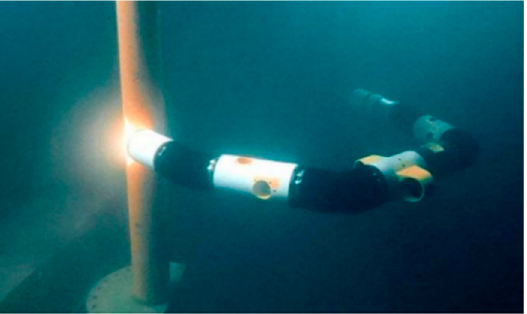
Figure 3. The Biotic AIAUV Eelume™ is repairing the underwater pipeline [13].